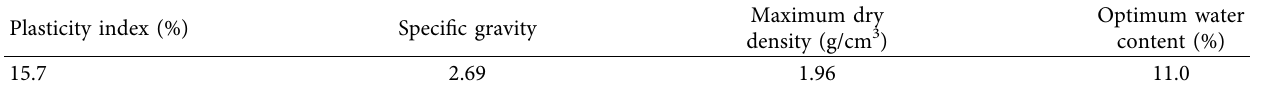
Table 1: Basic physical properties of soil.